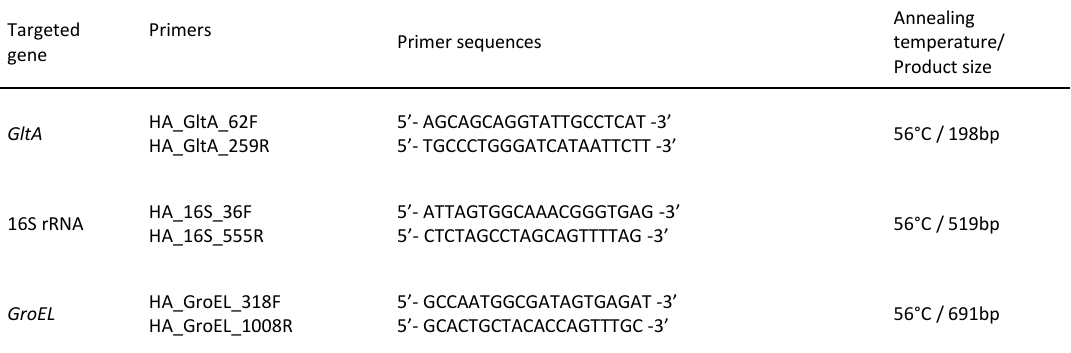
Table 2. PCR primers and conditions used for phylogenetic analysis of Ca. Hemipteriphilus asiaticus